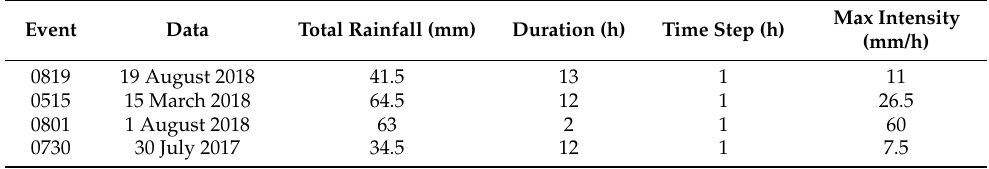
Table 2. Rainfall event